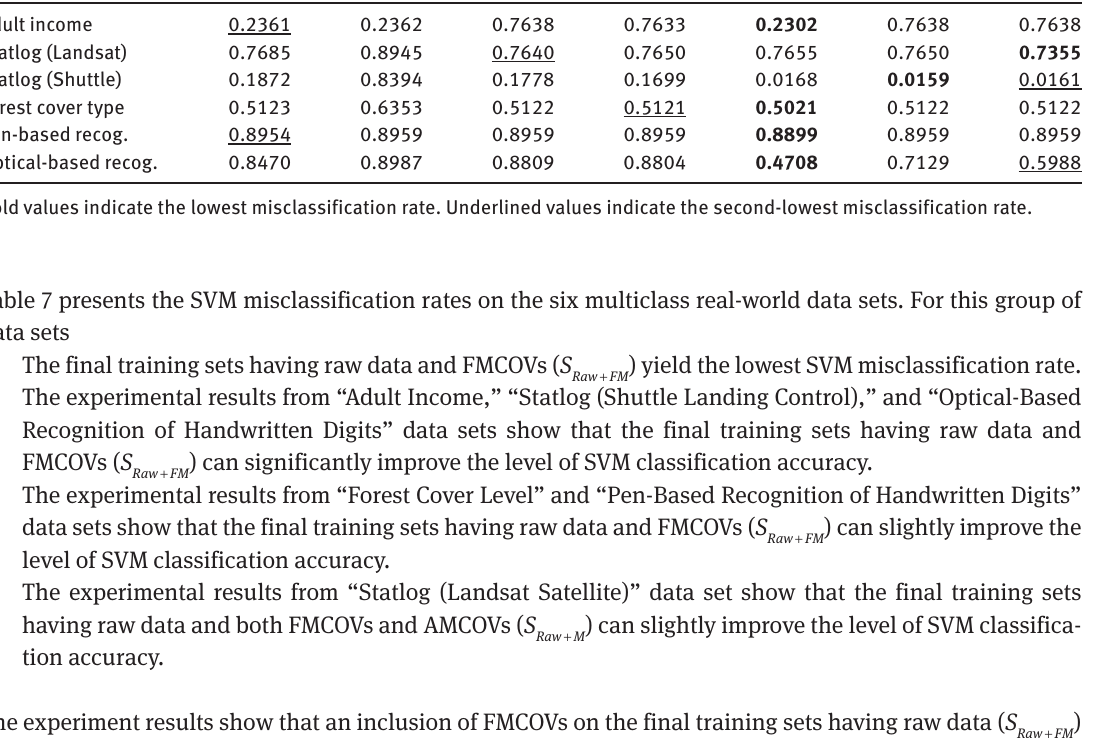
Table 7: SVM Misclassification Rates on the Six Multiclass Real-World Data Sets. Data